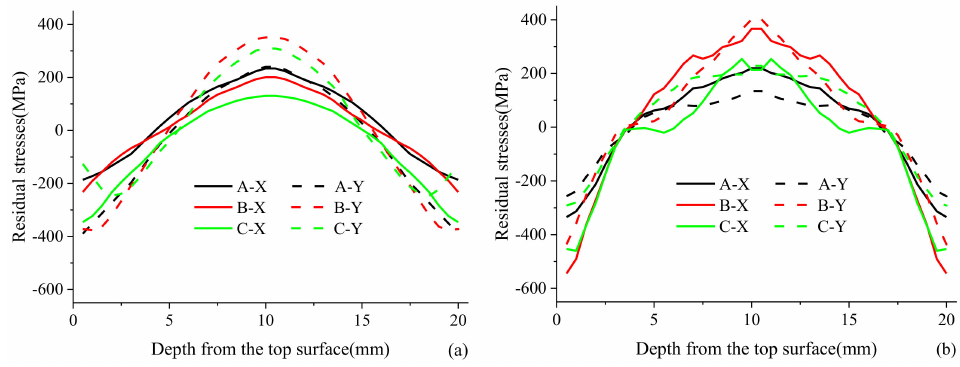
Figure 13. Distributions of residual stresses at depth: ( a ) simulation results; ( b ) measurement results. The depths of 0 mm and 20 mm are the top and bottom surfaces of the specimen, respectively. It shows compressive stresses on the surfaces and tensile stresses in the center. The curves are nearly parabolic, as the peak values of compressive and tensile stresses appear on the surfaces and center, respectively. According to the stress distribution state, the best position of the part in the blank should be close to a quarter of the thickness of the blank from the surface. Compared with the center position of the part in the blank, the residual stress is reduced by 70%. Forging RS of GH4169 come from two main sources: the nonuniform plastic deformation during compression and the temperature gradients in cooling. The effective strain and temperature after compression are shown in Figure 14.